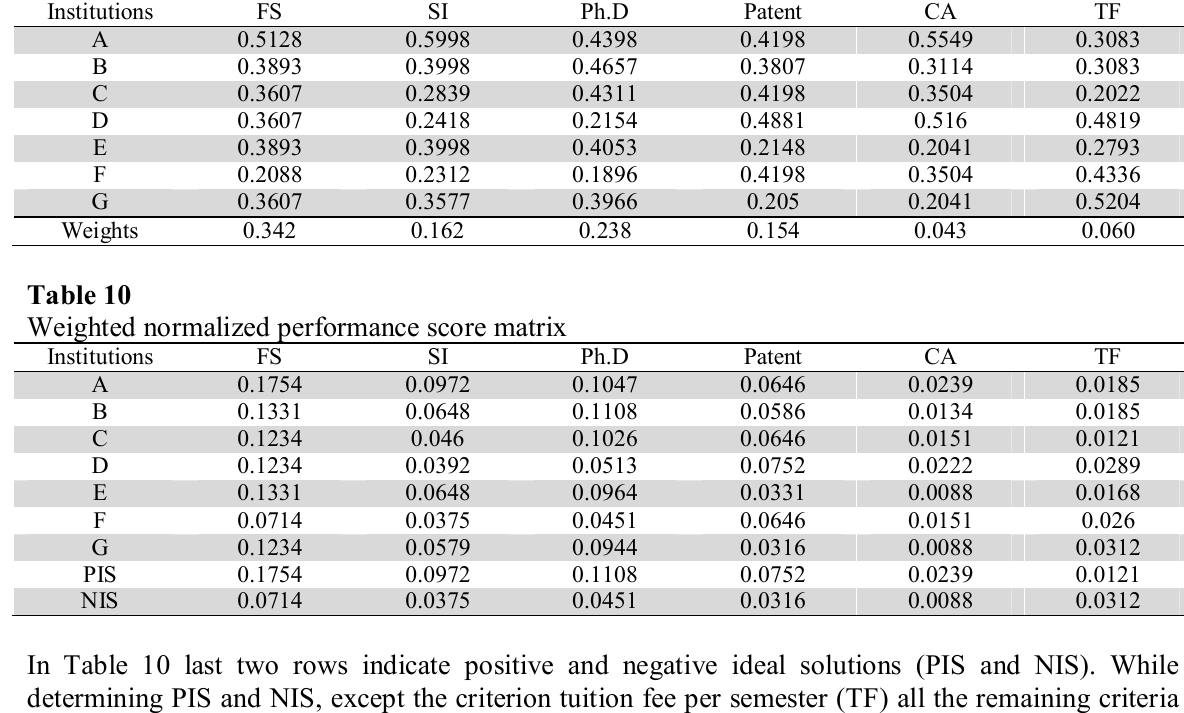
Normalized performance score matrix Institutions